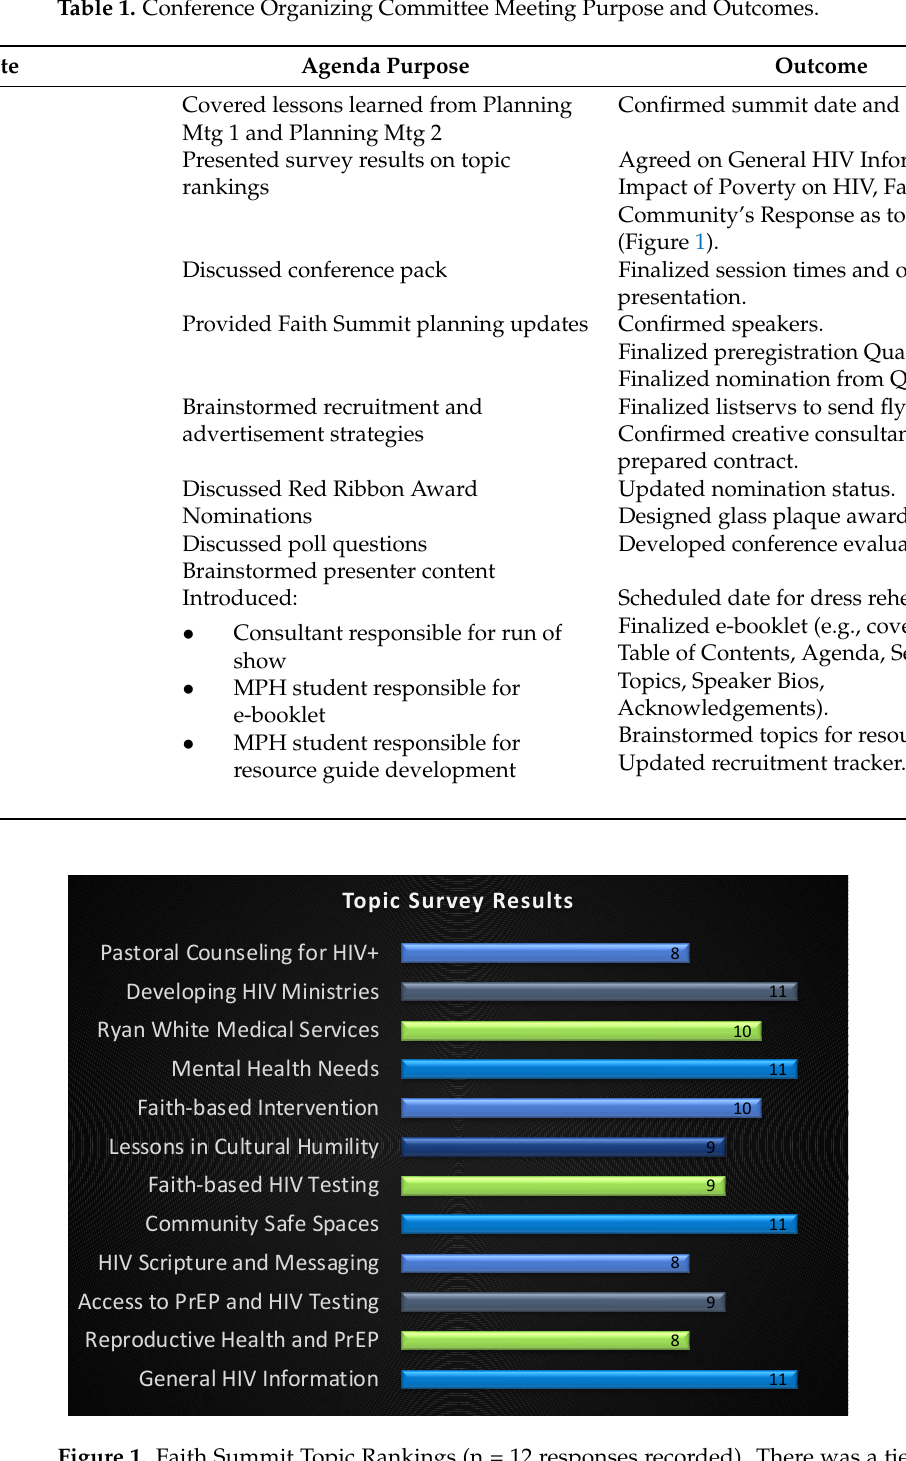
Table 1. Conference Organizing Committee Meeting Purpose and Outcomes.